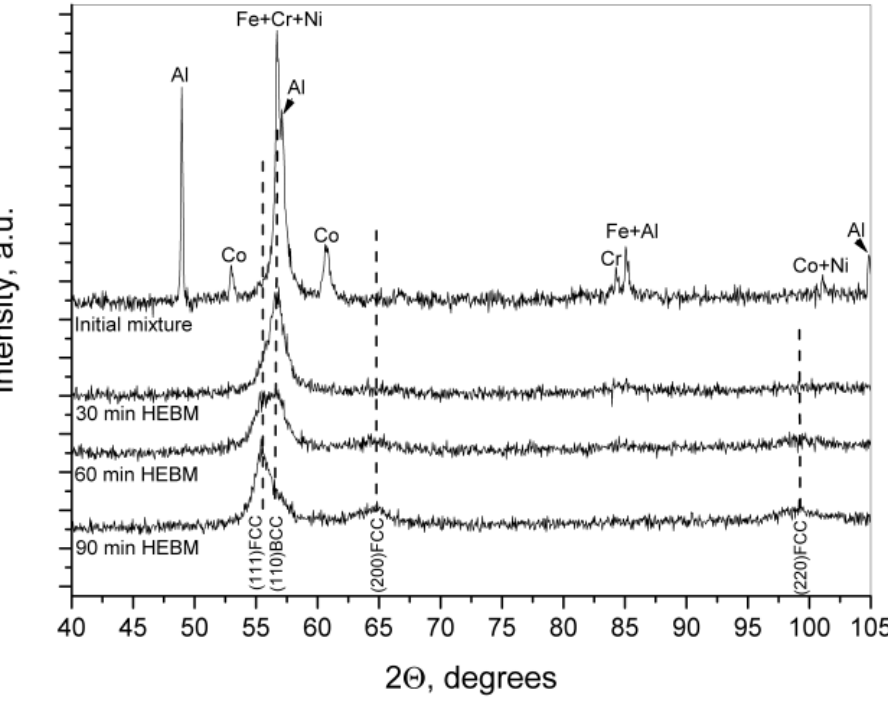
Figure 3. Di ff raction patterns (Fe- K α radiation) of CoCrFeNiAl mixtures before (upper curve) and after HEBM for 30 min, 60 min, and 90 min